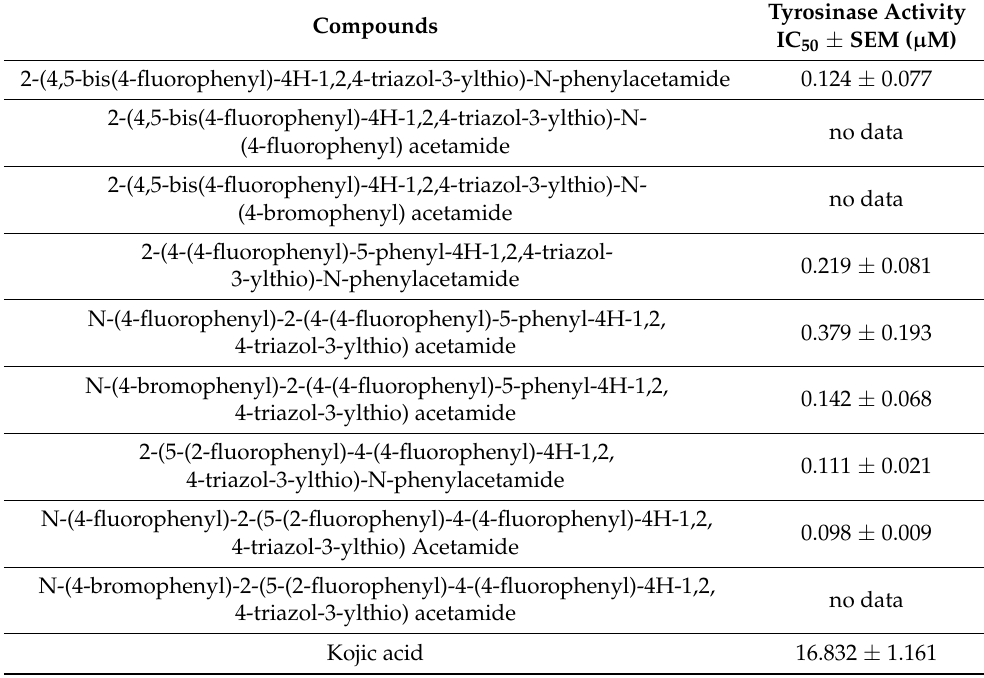
Table 1. Triazole-based derivatives with inhibition activity.